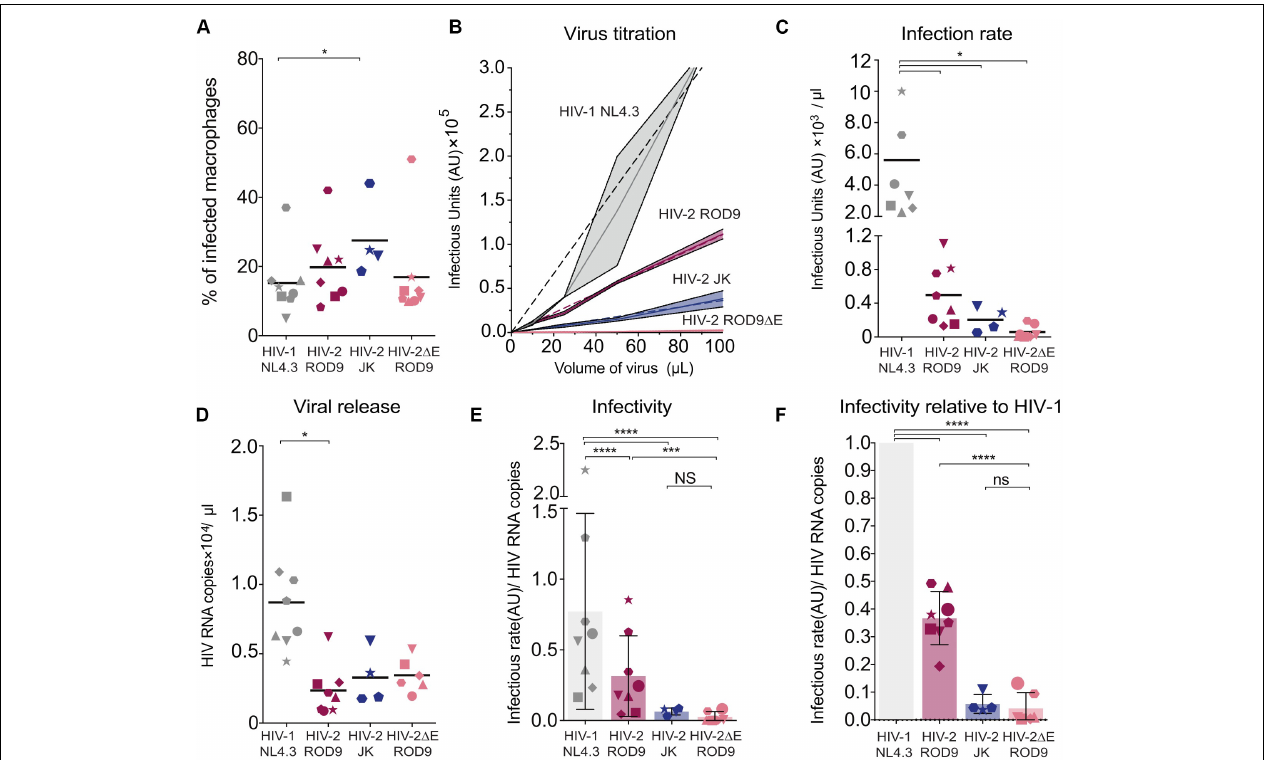
FIGURE 6 | Infected MDMs produce poorly infectious HIV-2 particles. MDMs were infected with the indicated viruses. MOIs were estimated on GHOST reporter cells and adjusted to reach similar infection rates in MDMs. n = 8 donors from 5 independent experiments, with bars representing the mean. Each symbol represents an individual donor across all the panels. (A) At 3 dpi, rates of MDMs infection were determined by flow cytometry. Percentages of infected MDM, i.e., GFP + , at 3 dpi. (B) Representative virus titration on the TZM-bl reporter cell line. Serial dilutions of supernatant from each type of HIV-infected MDM were added on TZM-bl cells. Infection rates (Infectious Units/ µ L) were determined by calculation of the slope of the titration curve built with technical replicates. (C) Infection rates determined as in (B) with MDMs from the 8 donors. (D) Viral RNA copies released at 3 dpi in the supernatant of HIV-infected MDMs evaluated by RT-qPCR. (E) Infectivity of the released viral particles, calculated as rate of infection and normalized by genomic HIV RNA copies. (F) Infectivity normalized to HIV-1 for each donor. P -values were calculated using paired Mixed-effect analysis with Geisser–Greenhouse correction for multiple comparison test. P -values lower than 0.05 were considered as significant (* p < 0.05, ** p < 0.01, *** p < 0.001, **** p <